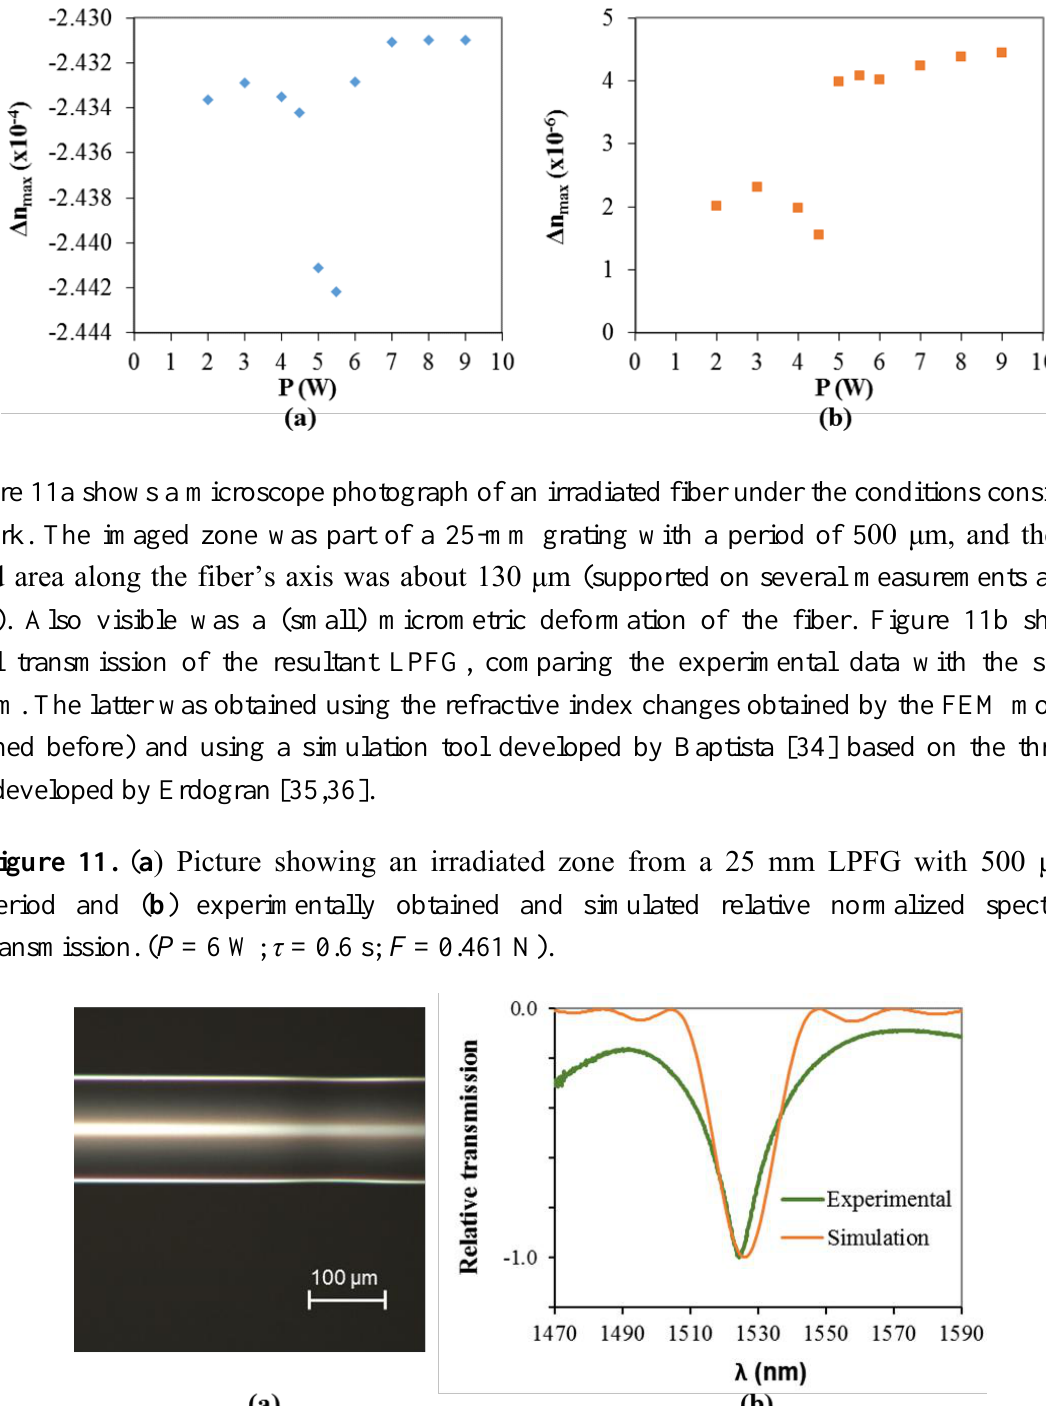
Figure 10. Calculated (maximum) refractive index change at the ( a ) core and ( b ) cladding for different applied laser powers. (τ = 0.6 s; F = 0.461 N).